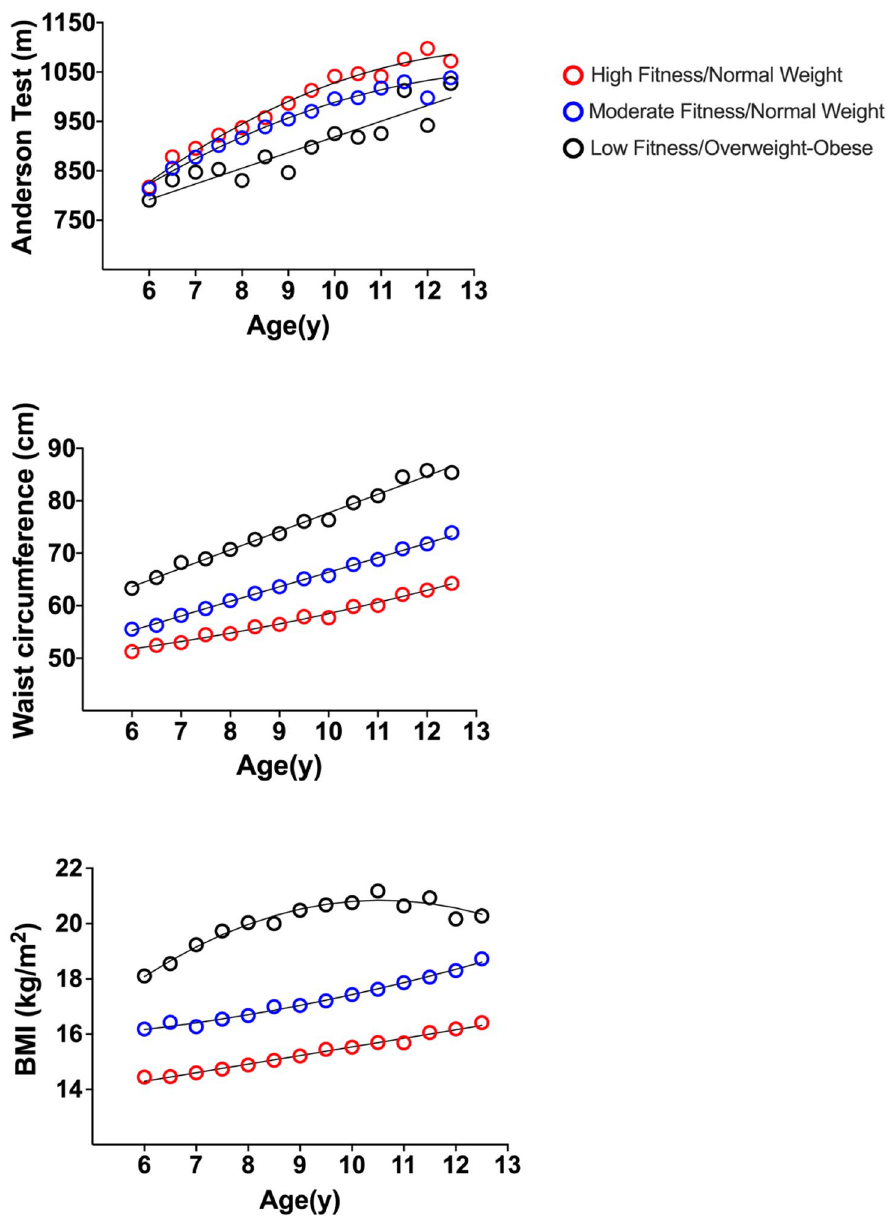
Figure 2. Developmental univariate trajectories of body mass index, waist circumference, and aerobic fitness for physically active children aged between 6 to 12.5 years.